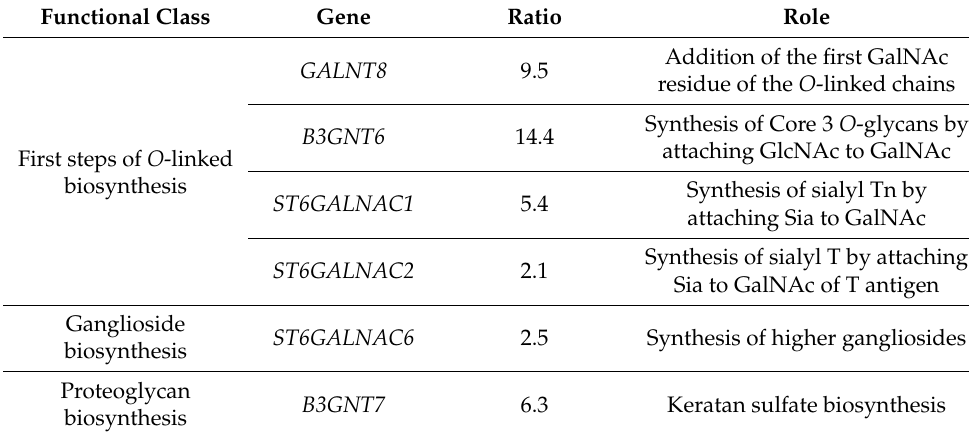
Table 2. Expression level of glycogenes in HBE and